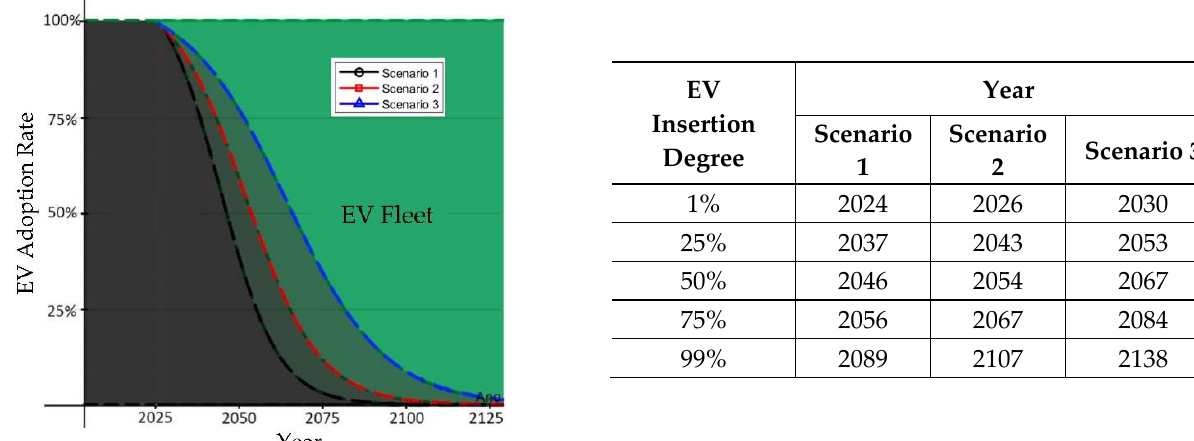
Figure 7. EV insertion and adoption rate—replacement behavior in relation to the total vehicle fleet in different scenarios.